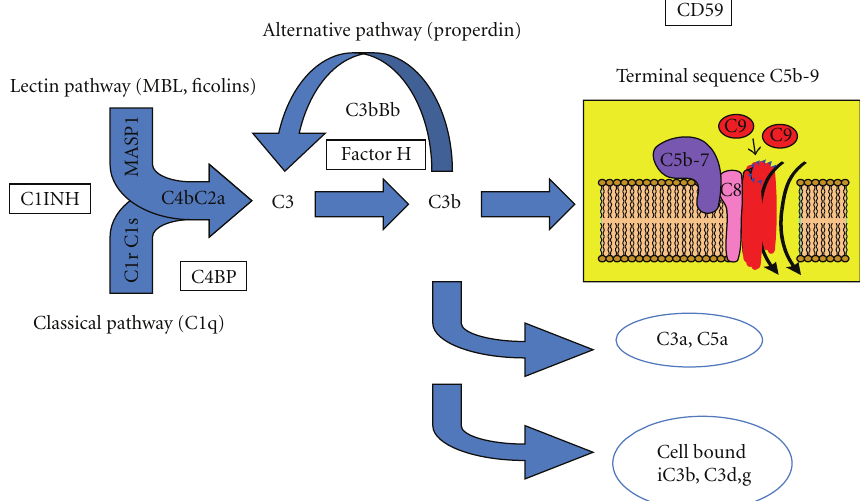
Figure 1: Overview of the complement system. Recognition by the lectin and classical pathways leads to the assembly of the C4b2a convertase, which cleaves C3. This reaction is greatly amplified by the alternative pathway, generating more C3b, and ultimately initiating the terminal sequence. The fluid phase anaphylatoxins, C3a and C5a, together with the cell-bound opsonins iC3b and C3d,g, facilitate phagocytosis. The main inhibitor of each step in the cascade is indicated in boxes: C1INH for initiation, C4BP for the classical pathway, factor H for the alternative pathway, and CD59 for the terminal